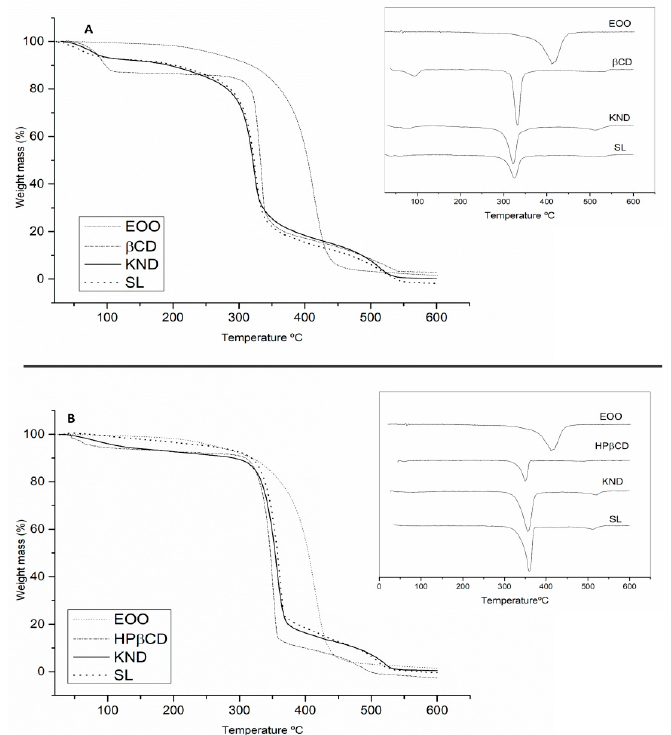
Figure 5. TG/DTG curves of E. oleracea oil (EOO), β -cyclodextrin ( β -CD), and EOO- β -cyclodextrin